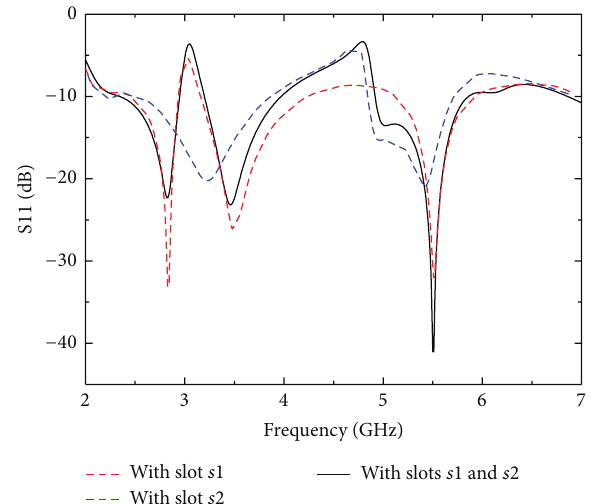
Figure 6: Comparisons of the introduced different slots on the return loss of the antenna.